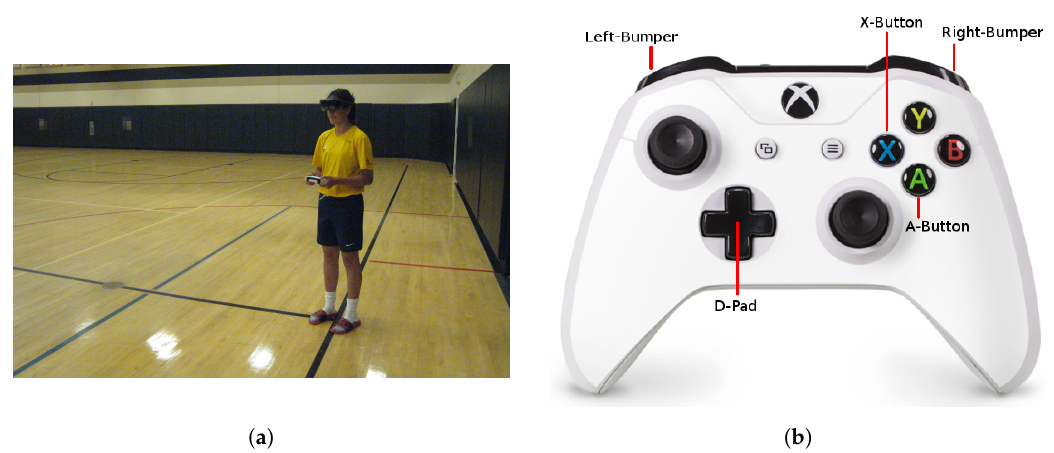
Figure 7. ( a ) This figure depicts the Microsoft Hololens/AR Set Up; ( b ) This figure shows a detailed view of the Xbox One S controller with button names as used in Table